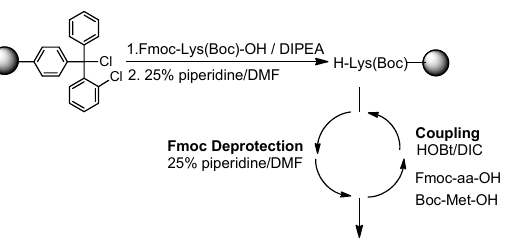
Scheme 2. Procedure for the synthesis of the cyclic mutated analogues of MOG 35–55 .